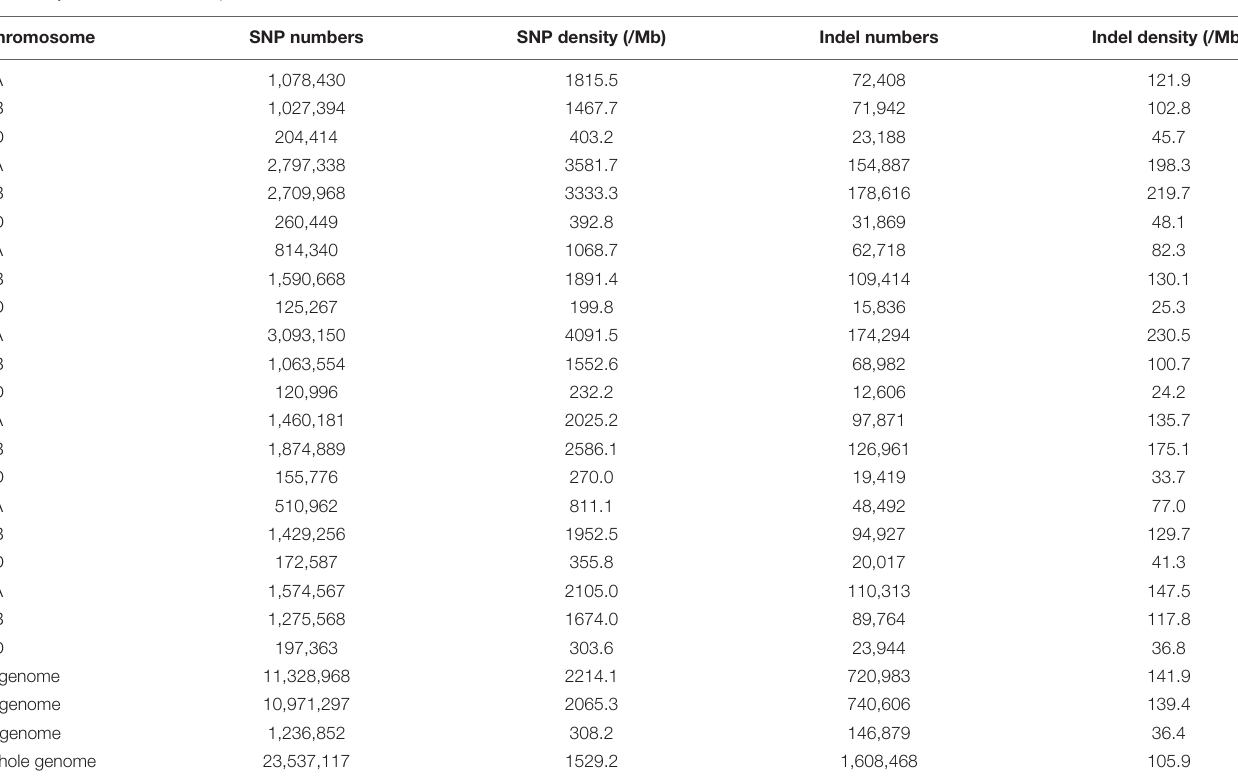
FIGURE 1 | Diagrammatic distribution of SNP frequency across 21 chromosomes. The rectangle represents a distribution of SNP frequency in each chromosome. The x -axis indicates the physical position on the chromosomes and the y -axis shows the SNP number in every million bases. TABLE 2 | Numbers and density of SNP and Indel variations on all